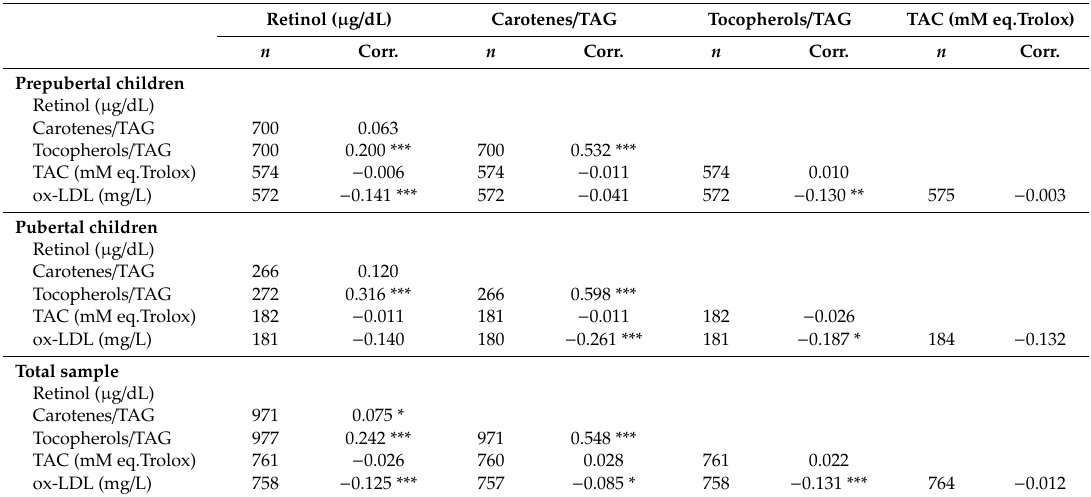
Table 3. Partial correlation analyses between analyzed plasma antioxidants and ox-LDL. Retinol ( µ g / dL) Carotenes / TAG Tocopherols / TAG TAC (mM